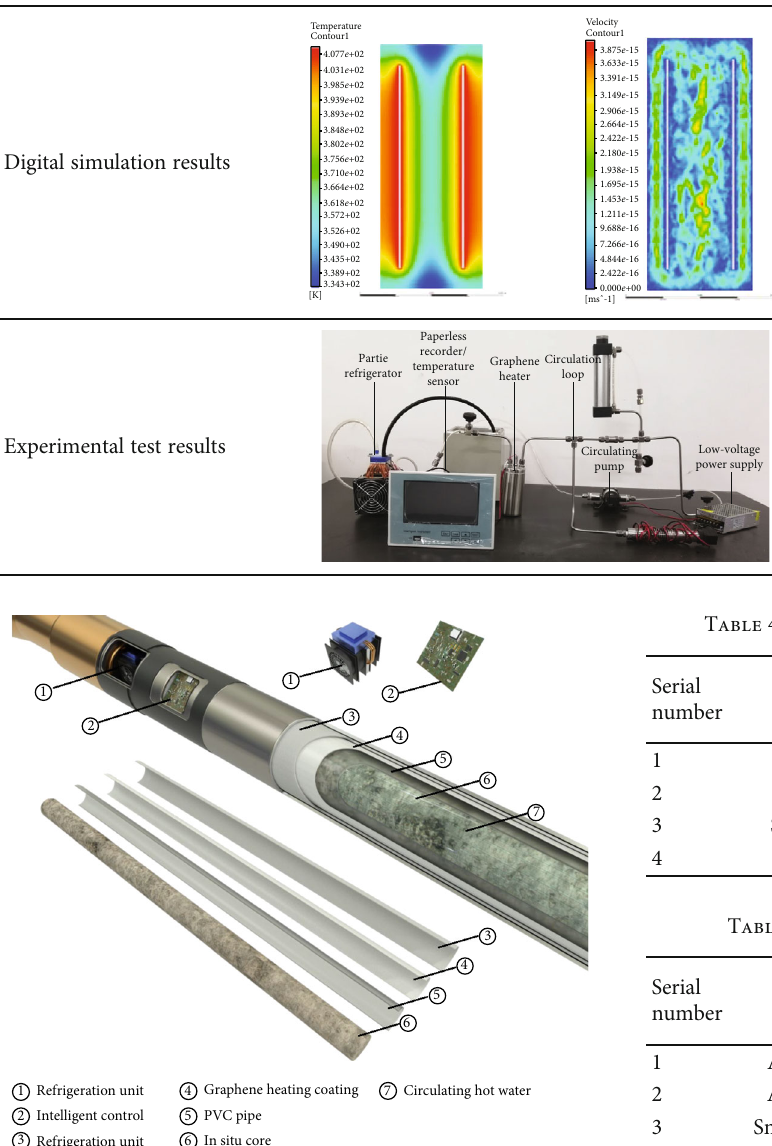
Figure 11: The high- fi delity digital twin model.